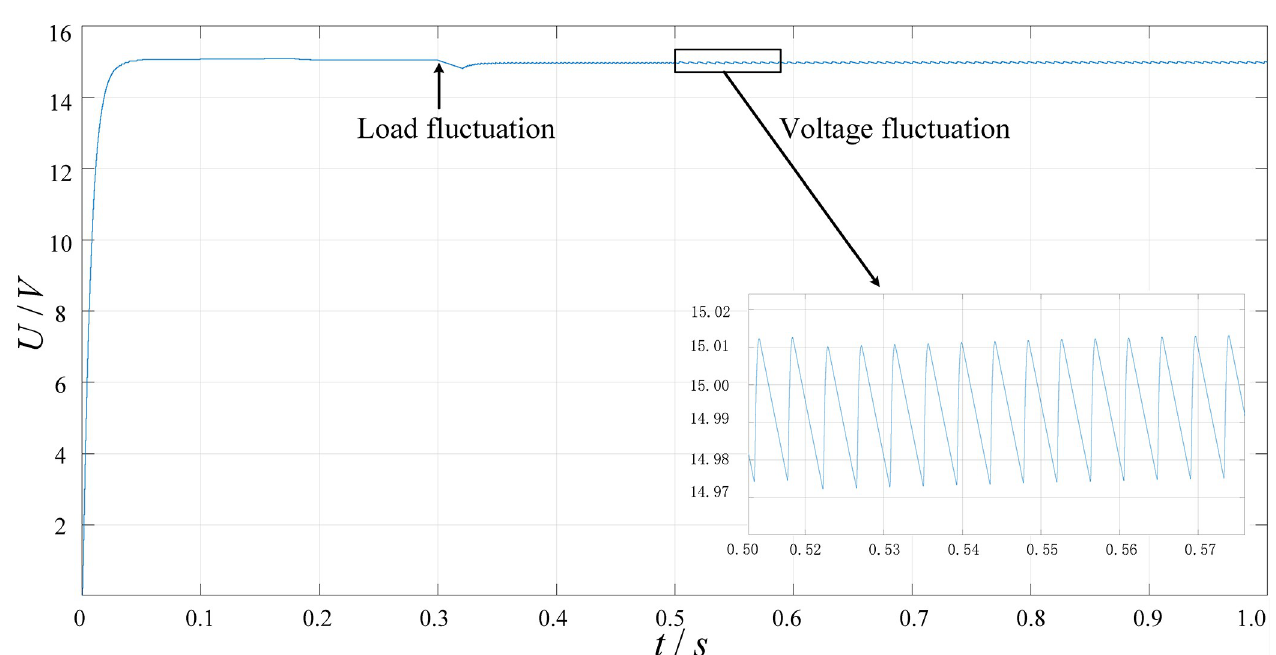
Fig 24. The waveform of the output voltage of the low-voltage charging circuit.